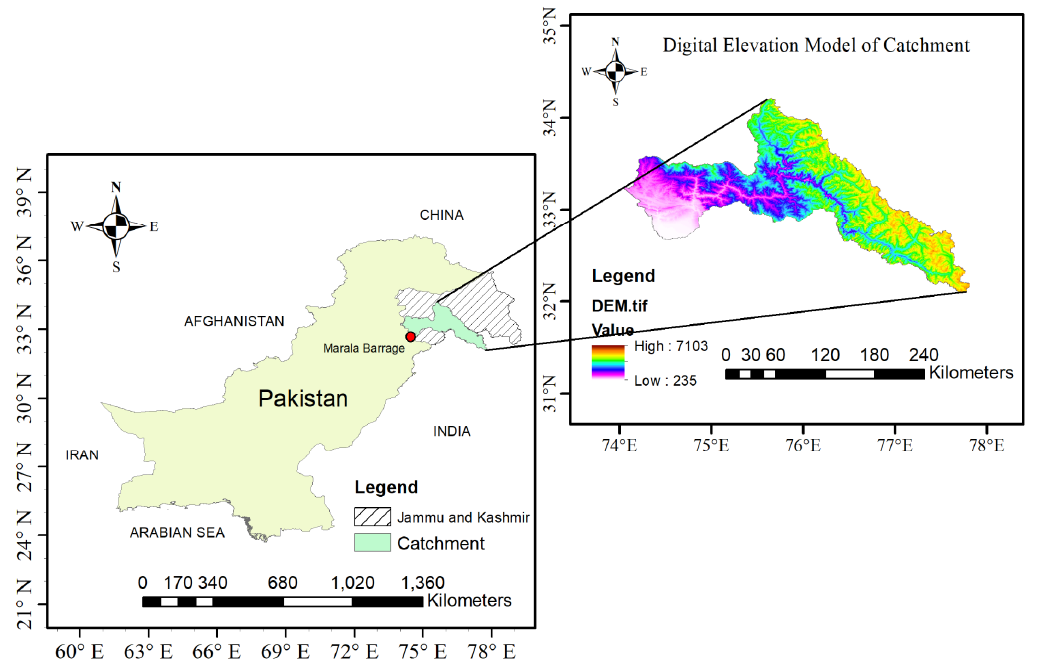
Figure 2. Visualization of the study area.